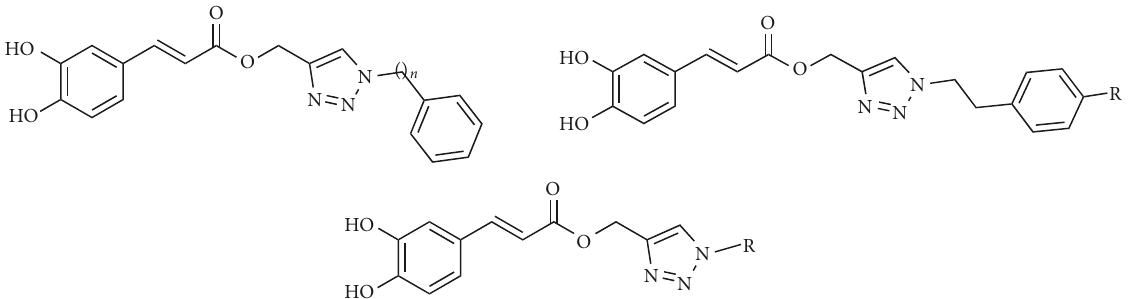
Figure 2: Caffeic acid phenylethyl ester analogs bearing substituted triazole designed in this